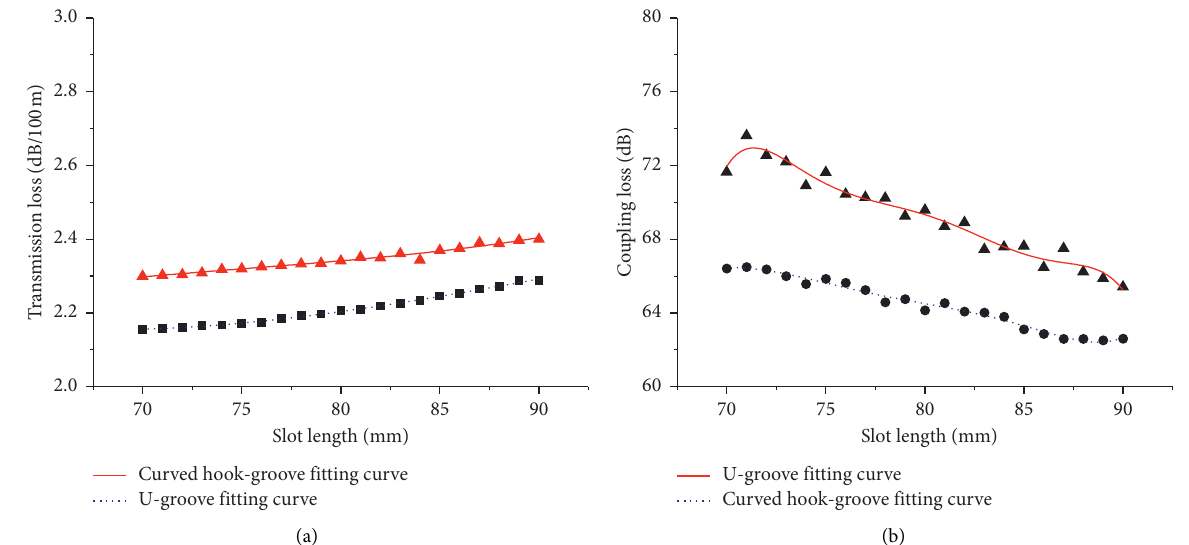
Figure 13: Trend of influence of overall groove length of U-groove and curved hook groove on leakage cable loss.